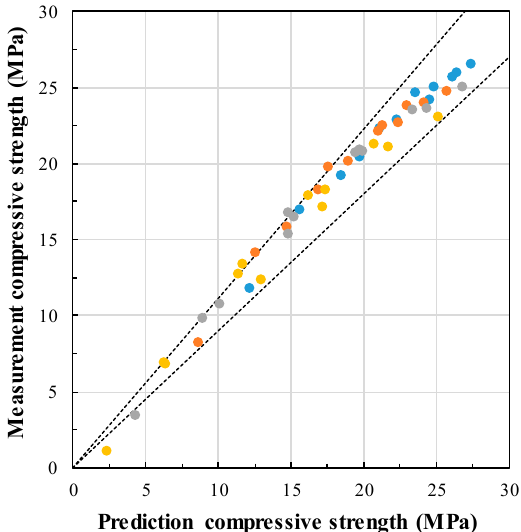
Figure 10. Comparison between predicted compressive strength and Measurement compressive strength.